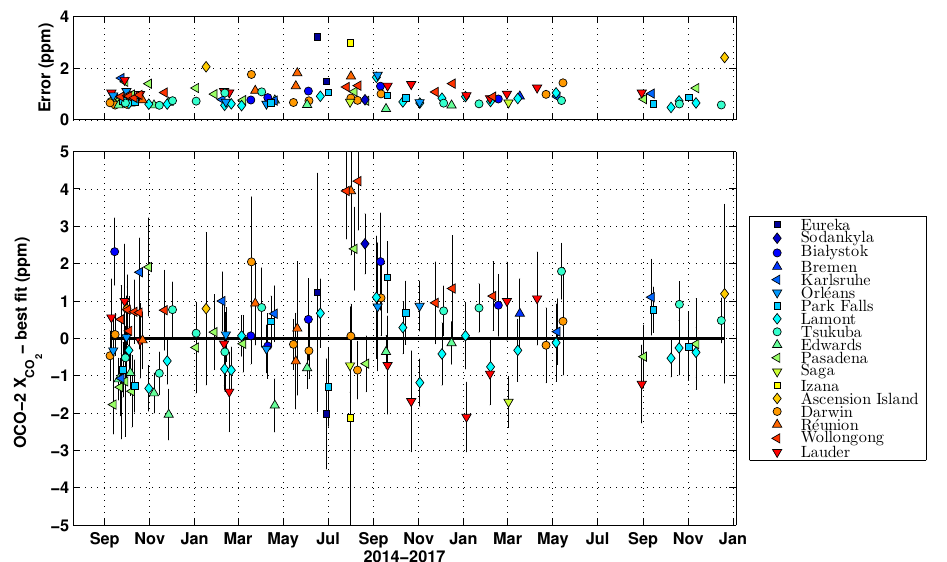
Figure 5. The time series of the differences between the OCO-2 target-mode data and the best fit line in Fig. 4c. The top panel shows the magnitude of the sum in quadrature of the standard deviation of the OCO-2 data during the target and the standard deviation of the coincident TCCON data. Those values are plotted as the error bars in the lower